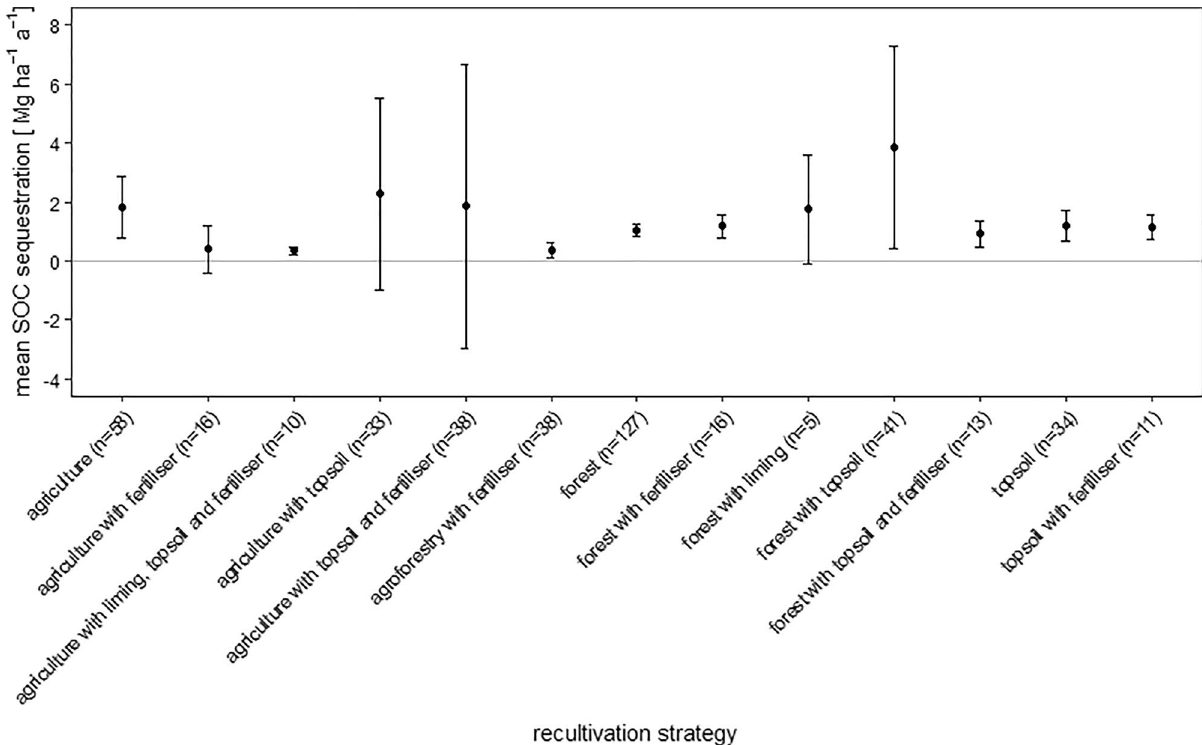
Figure 4. Mean annual SOC sequestration rate [Mg ha −1 a −1 ] of all 13 recultivation strategies.